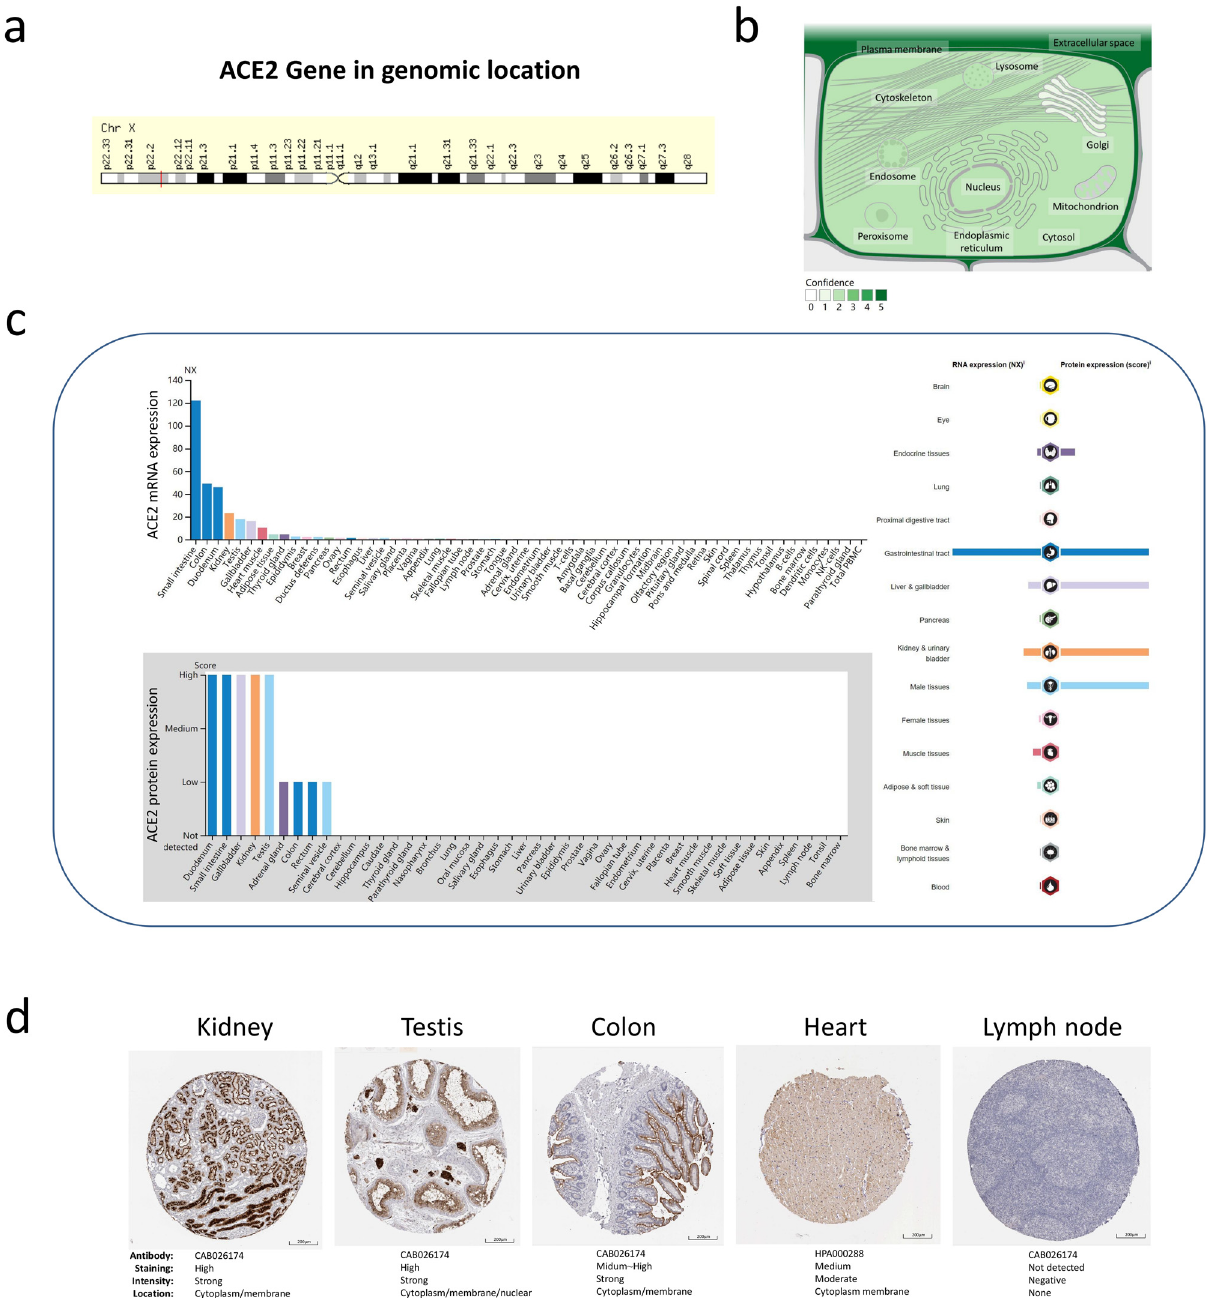
Figure 1: Location and expression of ACE2 in normal tissues. ( a ) Genomic location of the ACE2 gene obtained from GeneCard. ( b ) Cellular location of the ACE2 gene ( COMPARTMENTS ) . Con fi dence scale is color coded, ranging from light green for low con fi dence to dark green for high con fi dence. White indicates the absence of localization evidence. ( c ) The mRNA ( left side top, Consensus dataset ) and protein ( left side down ) expressions of ACE2 in normal tissues from the HPA. Color - coding is based on tissue groups, each consisting of tissues with common functional features. ( d ) Respective images of normal tissue with IHC staining of ACE2 protein in the HPA ( scale 200 µm ) . ACE2: angiotensin - converting enzyme 2; HPA: Human Protein